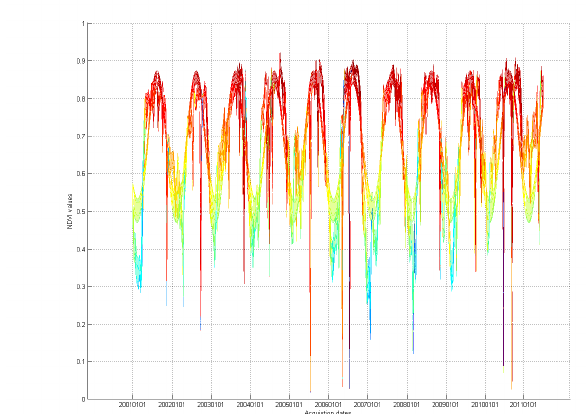
Figure 5. NDVI time-series in 2D for Otway CO2CRC during